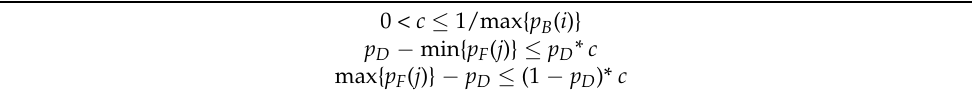
Table 3. Bounds on Scaling Parameters in Admissible Transformations For the Standard Binary Tree for Ordered Processes For probability parameters to be between 0 and